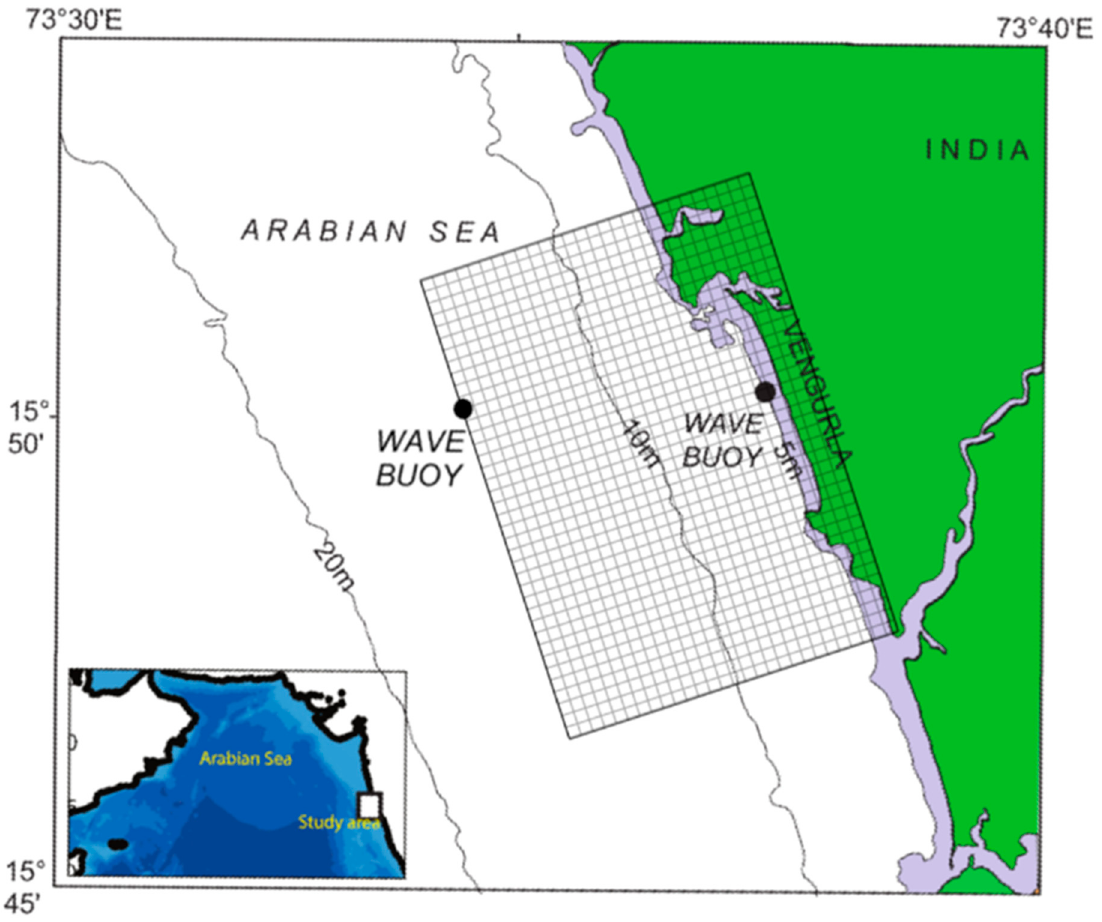
Figure 1. Study area in the eastern Arabian Sea showing the locations of the wave rider buoys at 15 and 5 m water depth. The rectangular box represents the model grid and its and 5 m water depth. The rectangular box represents the model grid and its boundaries.